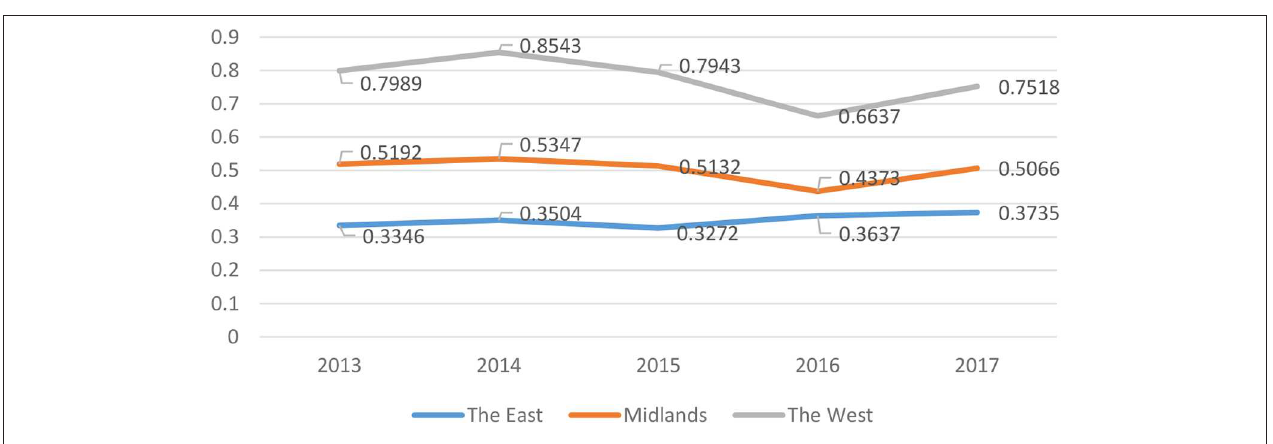
FIGURE 4 | Variation trend of total efficiency by regions from 2013 to